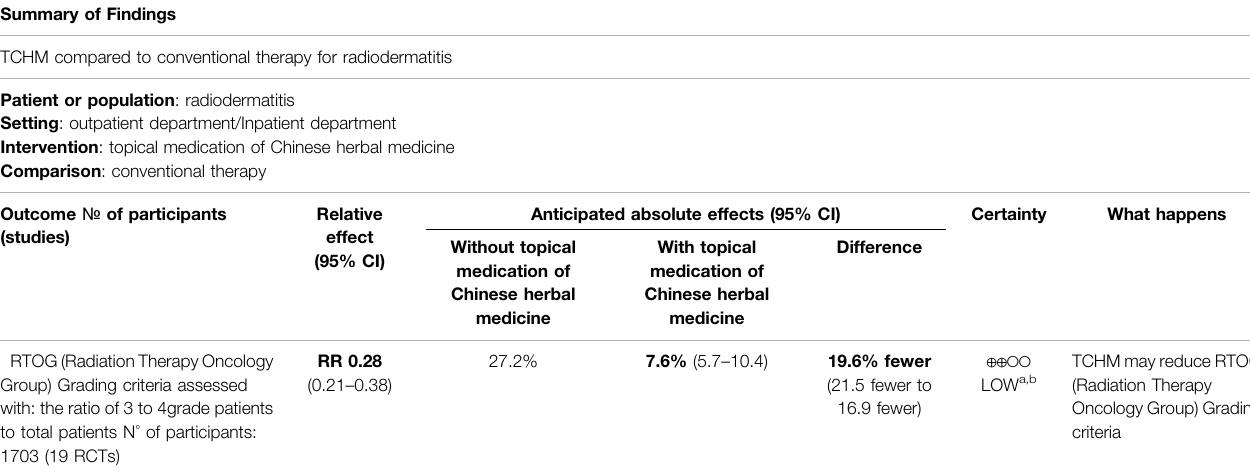
TABLE 4 | Summary of fi nding table of topical medication of Chinese herbal medicine compared to conventional therapy for radiodermatitis. Summary of Findings TCHM compared to conventional therapy for radiodermatitis Patient or population : radiodermatitis Setting : outpatient department/Inpatient department Intervention : topical medication of Chinese herbal medicine Comparison : conventional therapy Outcome № of participants